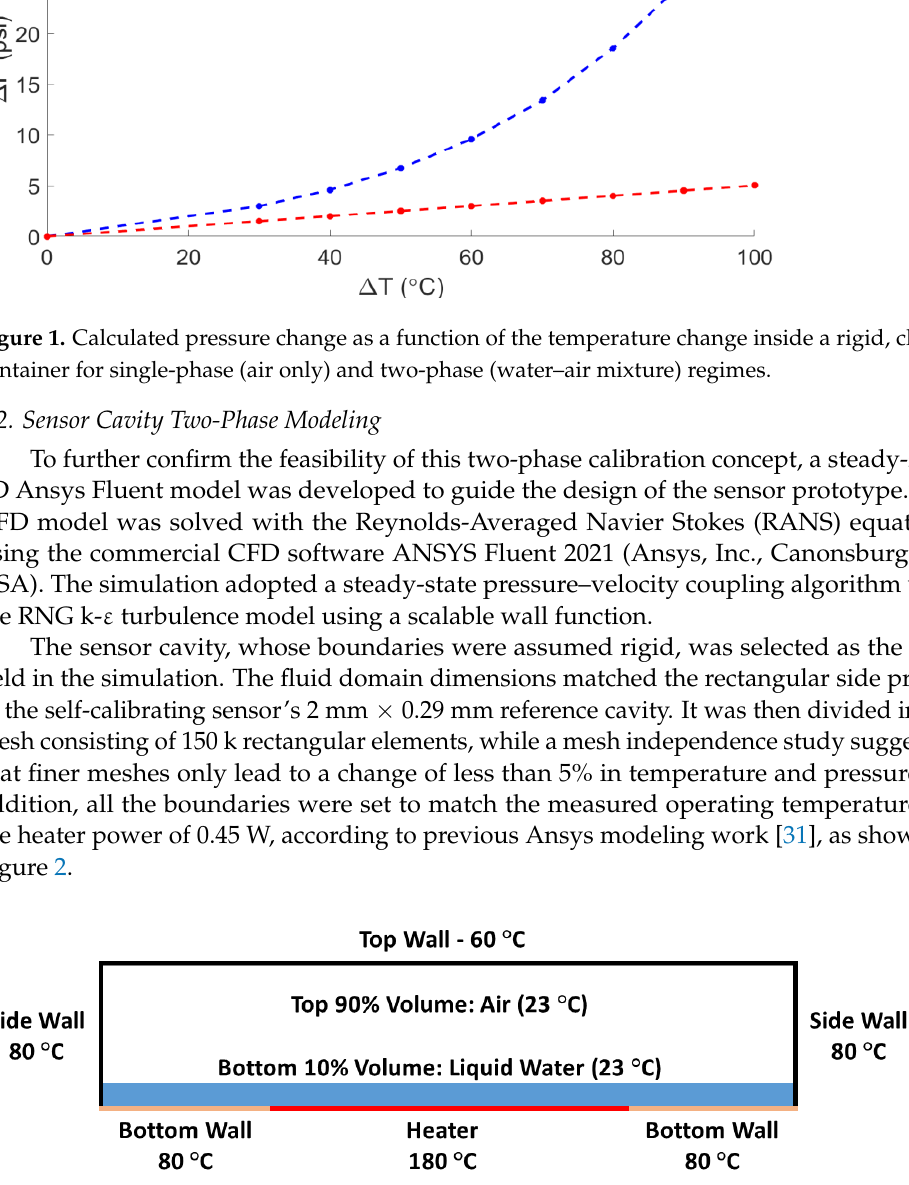
Figure 2. Initial and boundary conditions for the 2D two-phase sensor cavity Ansys Fluent model.